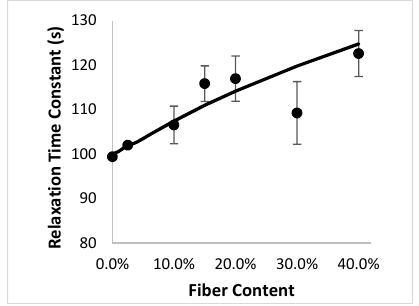
Figure 5. Good agreement is obtained between the relaxation rate constant obtained from the analytical model (-) and the finite element simulations ( ● ).